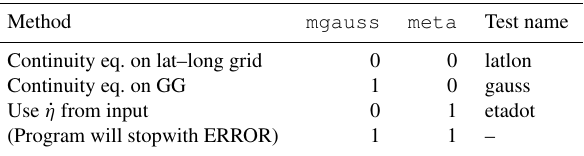
Table 15. Determination of the method for obtaining ˙ η in calc_etadot as a function of control parameters (see also Ta- ble 14). GG stands for Gaussian grid. The names of the correspond- ing regression tests (see Sect. 5.4) are also